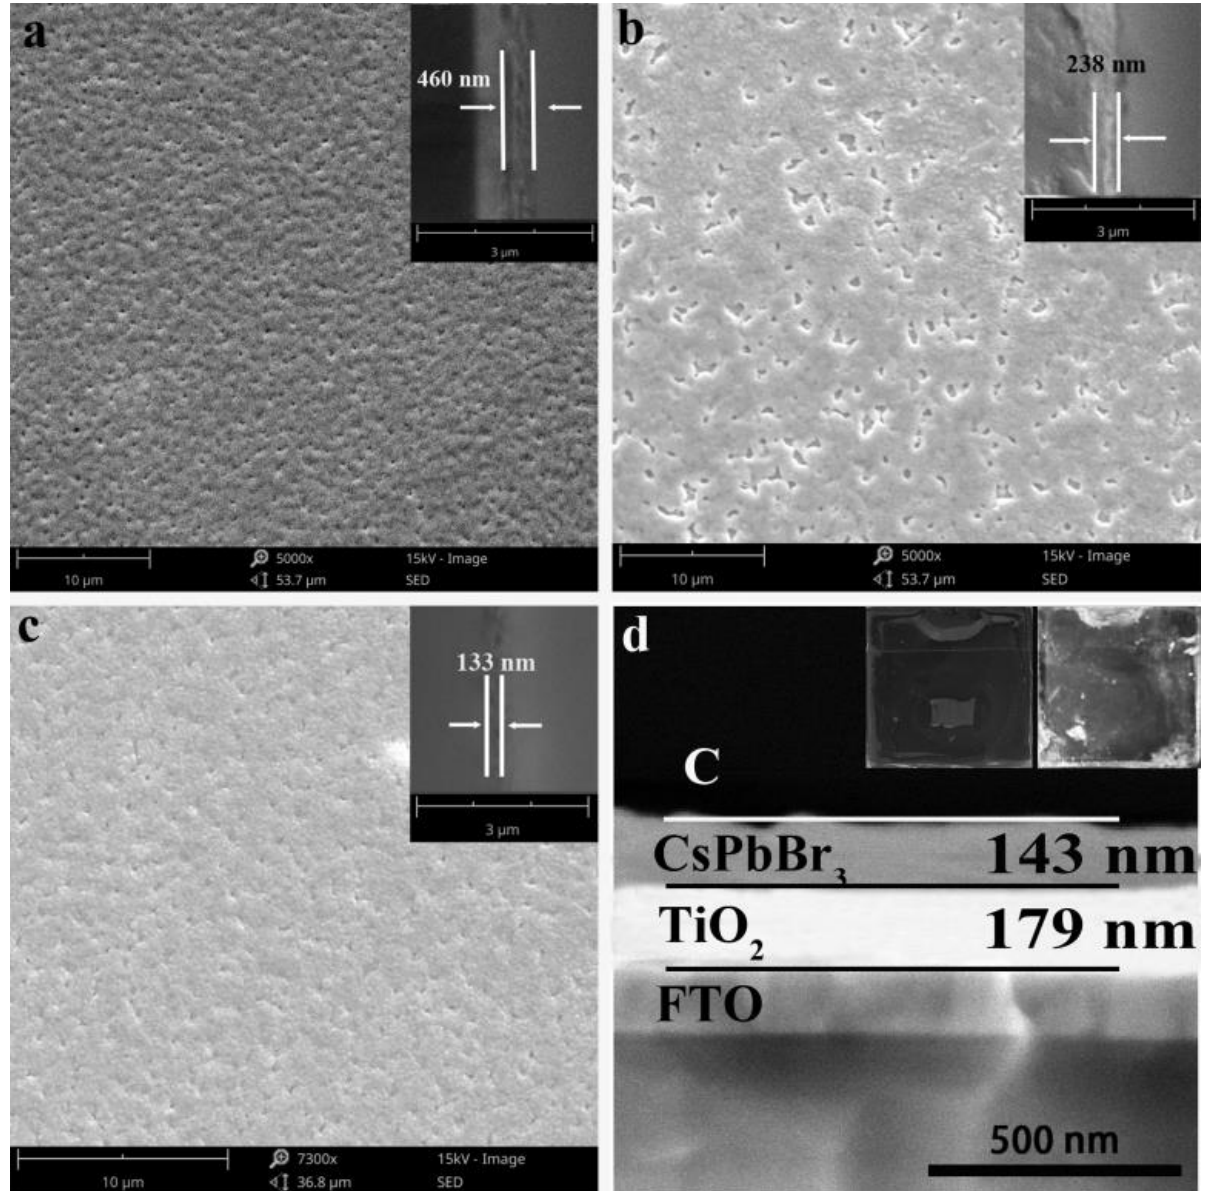
Figure 6. SEM images of front and cross-section of CsPbBr 3 layer at different spin-coating speeds: ( a ) 2000; ( b ) 3000; ( c ) 4000 rpm. The inset shows the section scan at the corresponding spin-coating speed. ( d ) A cross-sectional scan of the photocatalytic device illustrated with digital photos of the front and back of the packaged device.